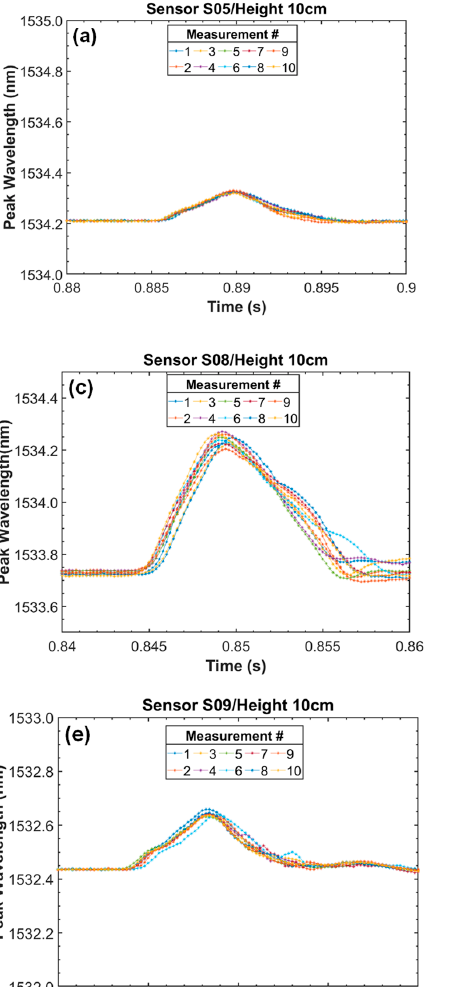
Table 3. Conversion between height and impact force.